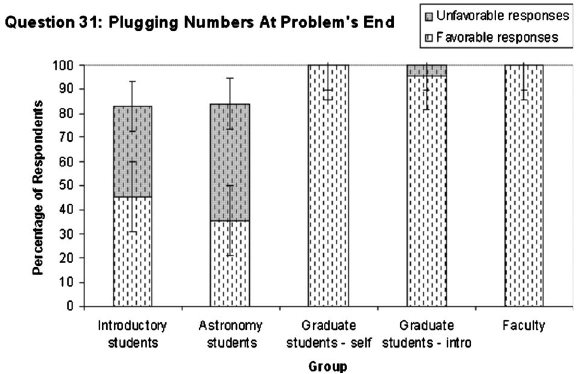
FIG. 7. Histogram showing favorable (cid:1) agree (cid:2) and unfavorable (cid:1) disagree (cid:2) responses for survey question (cid:1) 31 (cid:2) . The histogram shows that faculty and graduate students preferred to solve a problem sym- bolically first and only plug in the numbers at the very end but less than half of the introductory physics and astronomy students agreed with